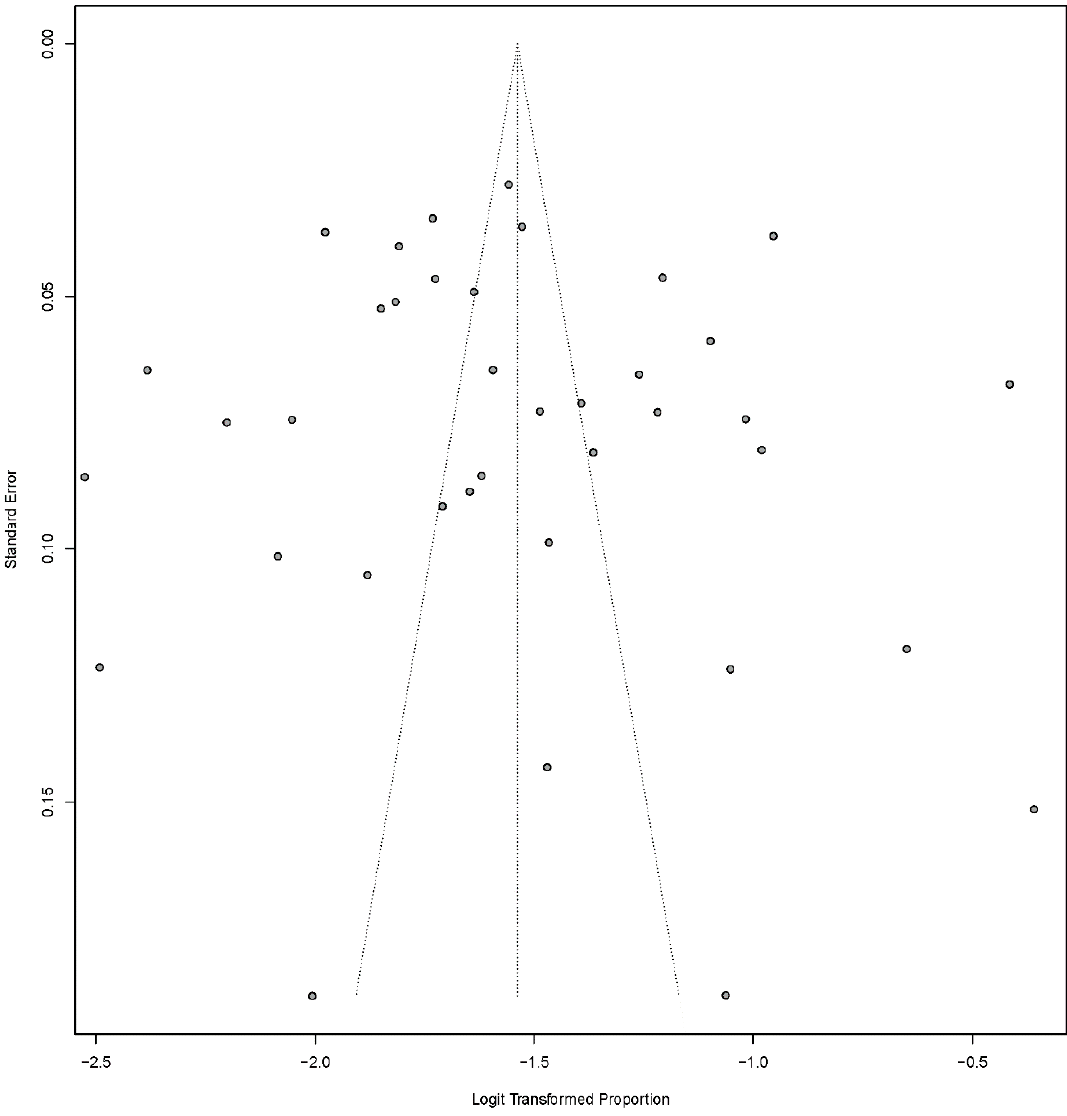
Figure 6. Funnel plot of prevalence of rotavirus-associated acute gastroenteritis cases in early childhood among Turkish children.